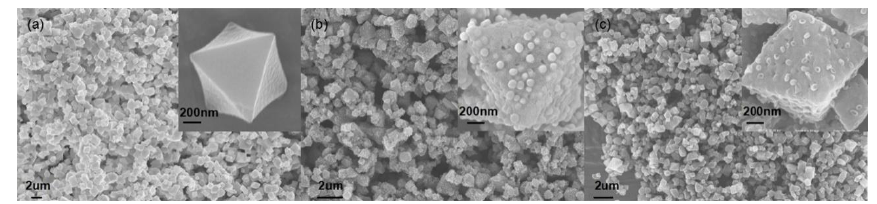
Figure 2. SEM images of ( a ) Cu-BTC particles; ( b ) Cu and porous carbon composites; and ( c ) C-SO 3 H particles.